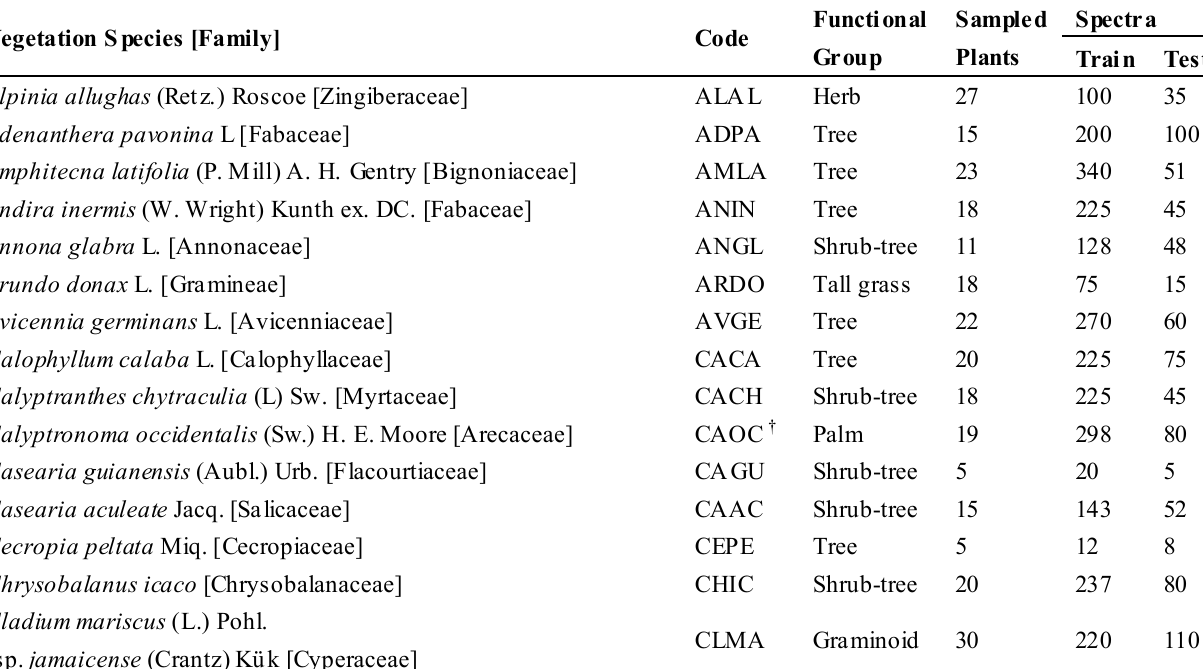
Table 1. Plant species used in this study and the number of spectra used as training and testing samples for data analysis and classification ( † endemic